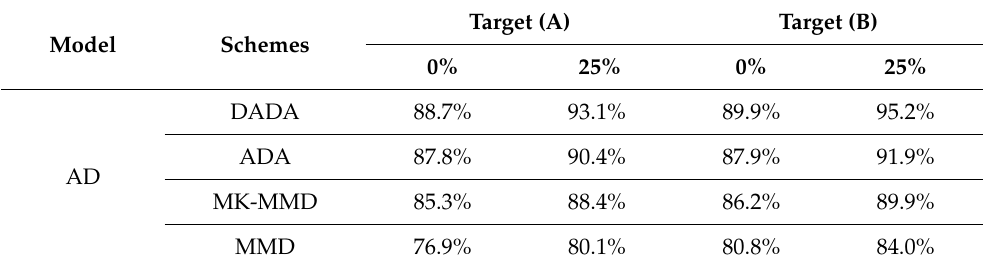
Table 4. Recognition accuracy (RA) with data augmentation.